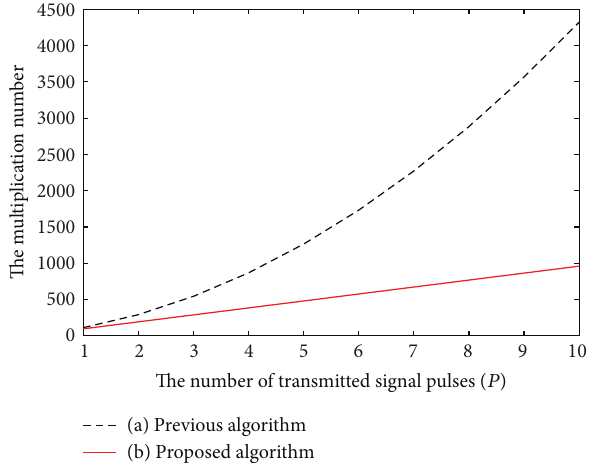
Figure 1: The multiplication numbers of two methods.